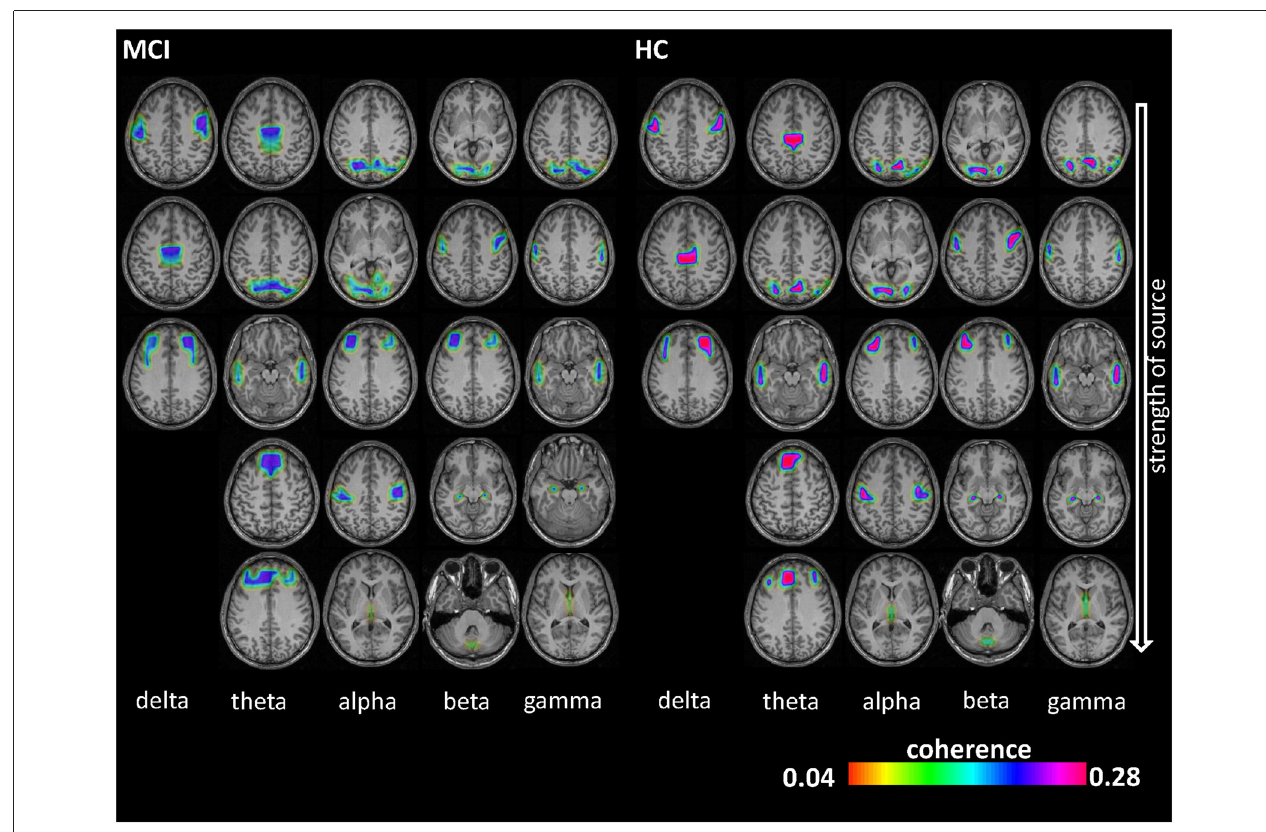
FIGURE 1 | Electroencephalography (EEG) coherence sources results. Coherence sources are shown for the five examined frequency bands: delta (1–3 Hz), theta (4–7 Hz), alpha (8–13 Hz), beta (14–30 Hz) and gamma (30–49 Hz). Coherence can range from 0 to 1 (i.e., two sources have temporally fully aligned time courses). Sources are displayed on a template T1-weighted brain. The first source (1) in each frequency band is the highest power source and was later used as reference for determining the subsequent coherent sources.